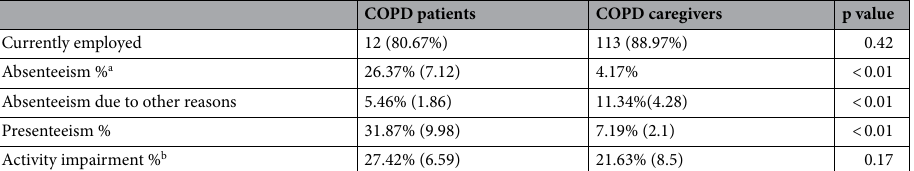
Table 3. Indirect cost of patients and their attendants. All results displayed as mean (standard deviation) unless otherwise stated; absenteeism, work time lost due to COPD or taking care of COPD patient; activity impairment, restriction in daily activities; presenteeism, reduced productivity while at work due to COPD or taking care of COPD patients. a Absenteeism % was calculated by dividing missing hours with total working hours. b For caregivers activity limitation was considered as social activity limitation due to taking care of COPD patient.